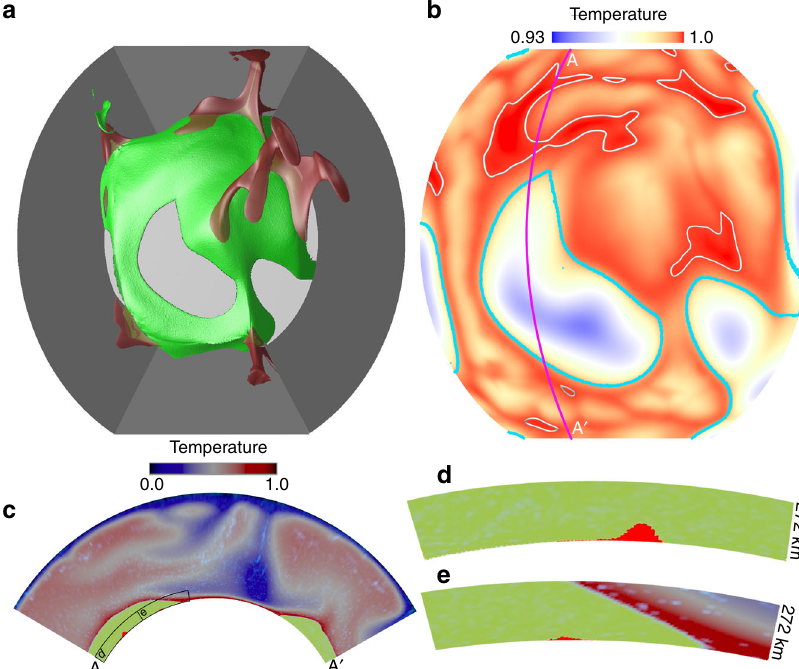
Fig. 1 Morphology and distribution of ULVZs caused by partial melting. a Top view of the model with mantle plumes ( red isosurface of temperature of 0.683) forming on tops of thermochemical piles ( green isosurface ). The gray side boundaries de fi ne the domain of the 3D partial spherical geometry of the model, which spans 120° in both longitudal and colatitudal directions. The downwellings (not shown) sweep pile material away, exposing the core ( light gray ) in these regions. b Temperature fi eld in map-view at 5 km above the CMB. Light gray contours at T = 0.999 show the hottest 10% regions of the piles by area. Thick cyan lines show the edges of piles. c Cross-section at locations marked by magenta line in Fig. 1b. The temperature fi eld is shown by dark blue to red color , the thermochemical piles are shown in green color in the lowermost mantle, and the small red patches within the piles at the bottom of the mantle show the hottest regions. d , e Zoomed-in at the regions outlined by black boxes in Fig. 1c. The hottest regions ( red patches inside the pile) are candidate regions for melting, and we identify the hottest regions where temperature is higher than mantle solidus. At 5 km above CMB, the hottest 10% pile regions by area are identi fi ed as candidate regions for melting by assuming a mantle solidus of T = 0.999 (non-dimensional) at this depth. For other depths, the mantle solidus decreases with decreasing depth with a rate of ~0.8 K km − 138 . All panels a – e are shown at 218